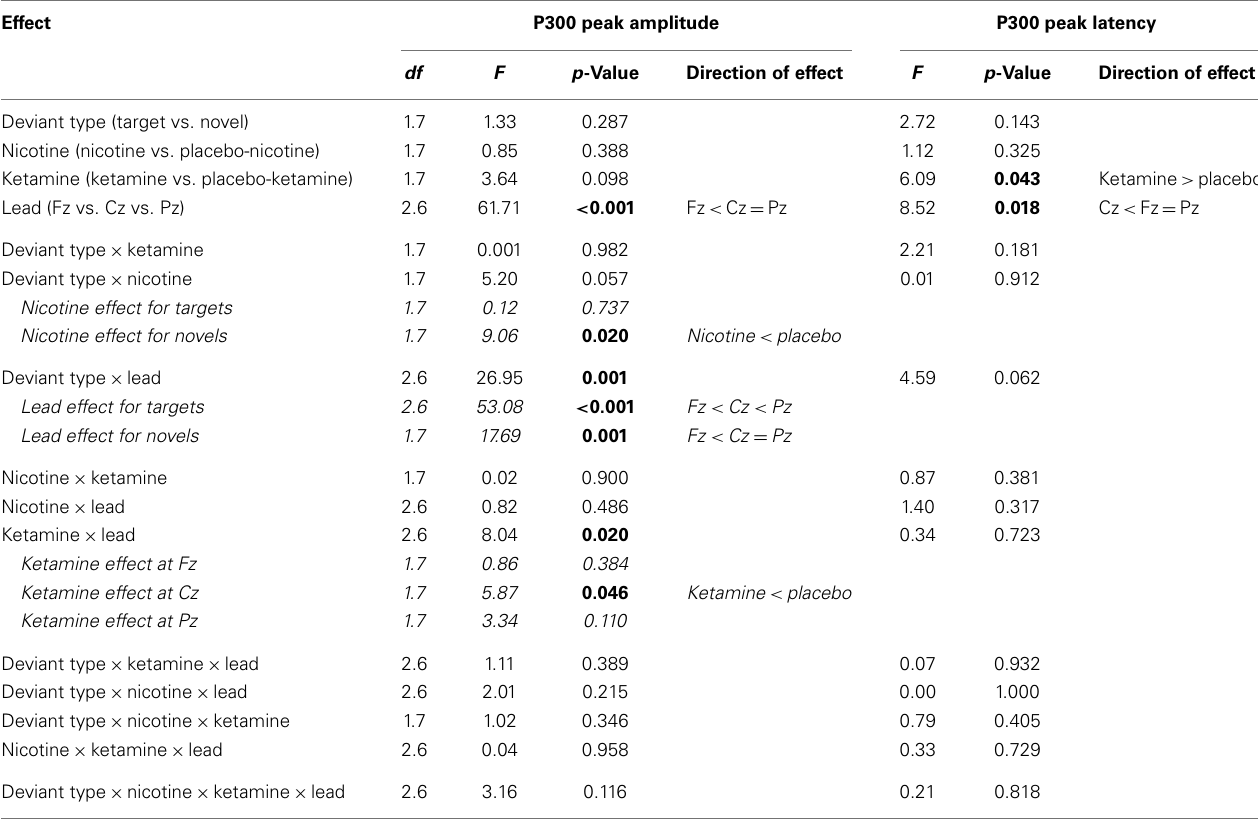
Table 5 |Analysis of variance (ANOVA) of P300 peak amplitudes and latencies .